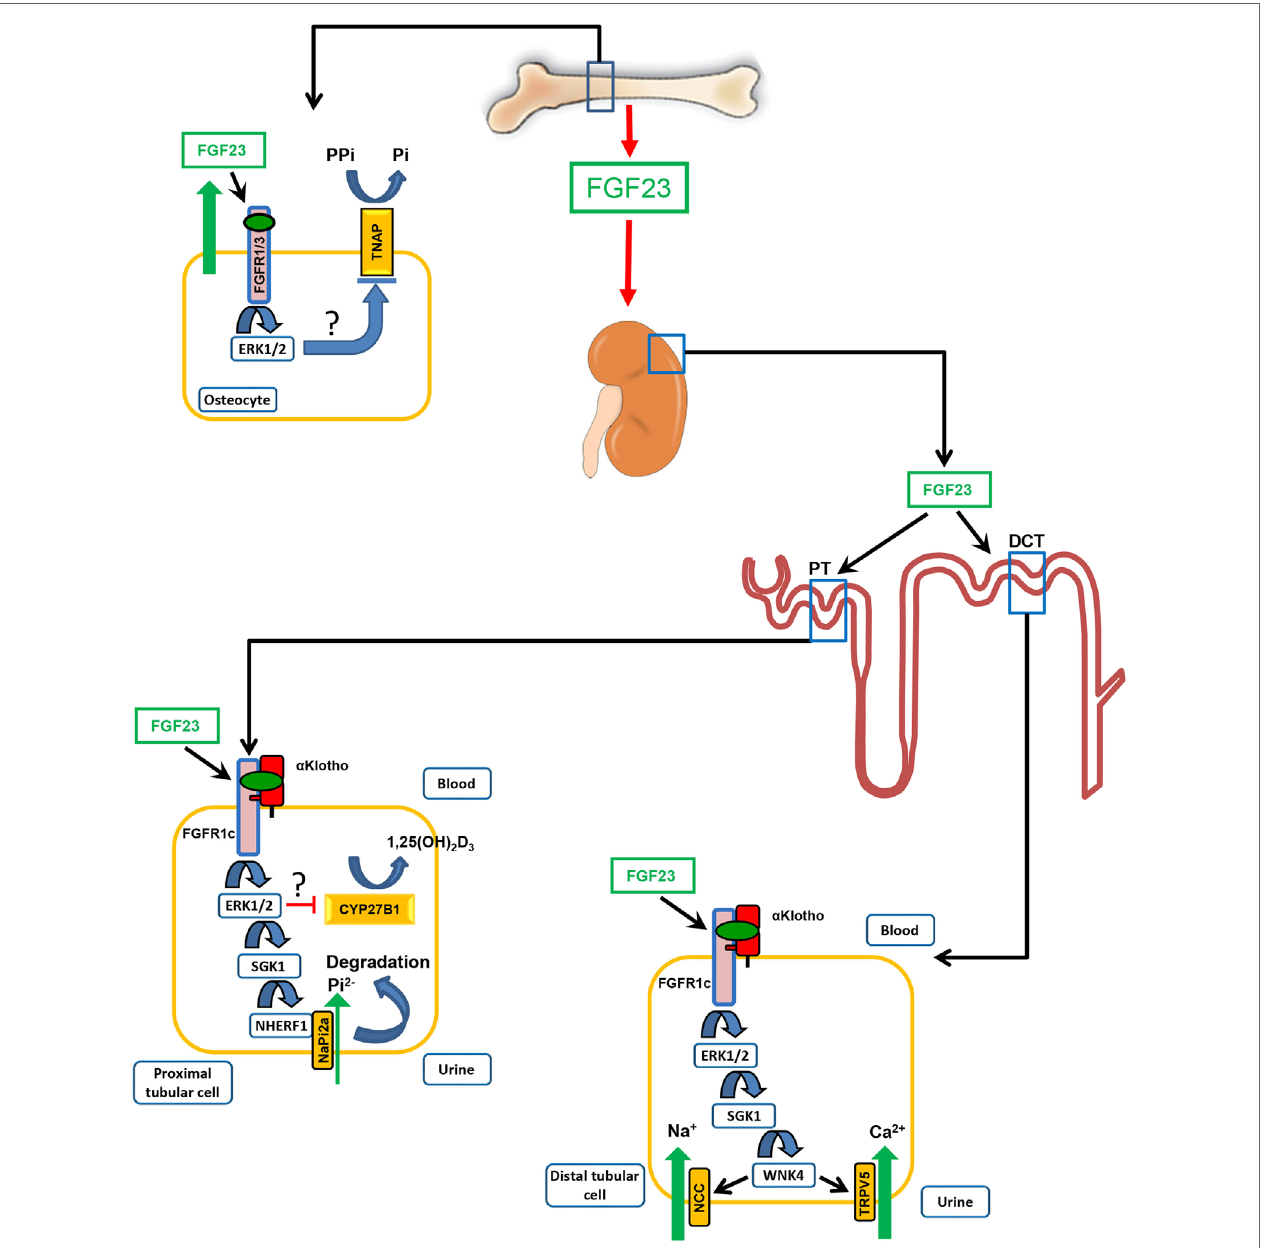
FiGURe 1 | Physiological functions of fibroblast growth factor-23 (FGF23). FGF23 is mainly produced in bone cells, osteoblasts, and osteocytes. One of the main target organs of the hormone FGF23 is the kidney. In the kidney, FGF23 acts on proximal and distal convoluted renal tubules. Binding of blood-borne FGF23 to FGF receptor-1c (FGFR1c) requires the presence of the co-receptor α Klotho. In renal proximal tubules (PT), FGF23 inhibits phosphate (Pi) re-uptake and expression of 1 α -hydroxylase (CYP27B1), the rate-limiting enzyme for vitamin D hormone (1 α ,25(OH) 2 D 3 ) production. The FGF23-mediated suppression of 1 α -hydroxylase transcription involves extracellular signal-regulated kinase-1 and 2 (ERK1/2) activation. However, the exact signaling pathway downstream of ERK1/2 is unknown. The inhibition of phosphate reabsorption in proximal renal tubules by FGF23 is mediated through activation of ERK1/2 and serum/glucocorticoid-regulated kinase-1 (SGK1), leading to phosphorylation of the scaffolding protein Na + /H + exchange regulatory cofactor (NHERF)-1. NHERF-1 phosphorylation triggers internalization and degradation of the sodium-phosphate cotransporter NaPi-2a, so that less NaPi-2a is available in the apical membrane for phosphate uptake from urine. In distal convoluted tubules (DCT), FGF23 increases reabsorption of calcium and sodium by increasing the apical membrane abundance of the epithelial calcium channel transient receptor potential vanilloid-5 and of the sodium-chloride cotransporter NCC through a signaling cascade involving ERK1/2, SGK1, and with-no-lysine kinase-4 (WNK4). FGF23 locally produced by osteocytes is an auto-/paracrine inhibitor of bone mineralization by down-regulating tissue non-specific alkaline phosphatase (TNAP) transcription in a α Klotho-independent fashion via FGFR1- or FGFR3-mediated activation of ERK1/2. The signaling pathway downstream of ERK1/2, leading to suppression of TNAP transcription, is not known. TNAP is essential for normal mineralization of bone by cleaving the mineralization inhibitor pyrophosphate